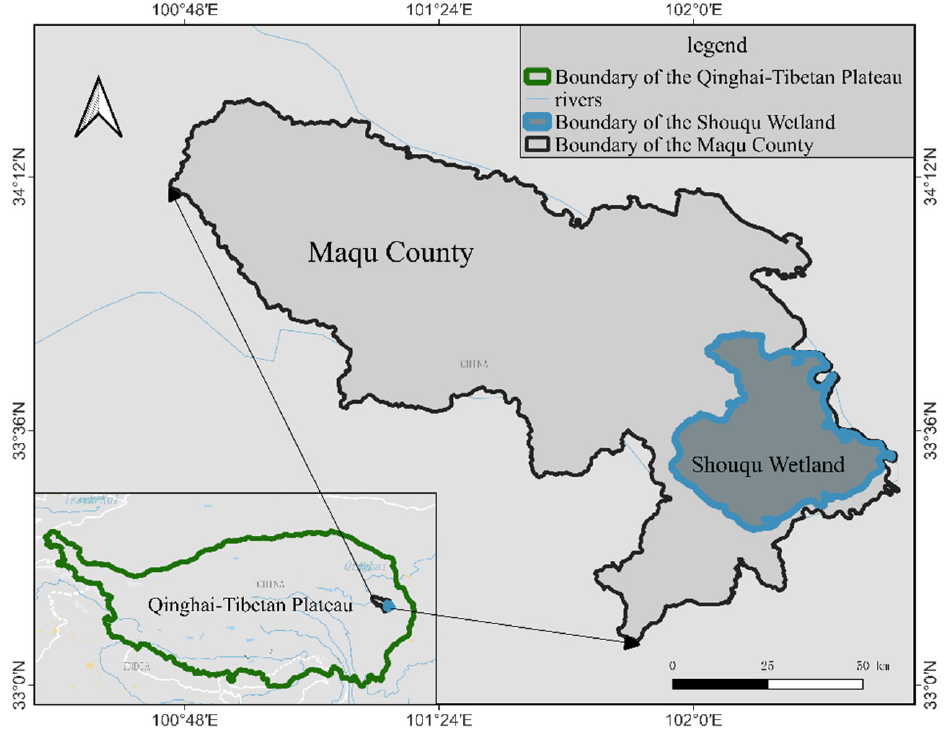
Figure 1. Map showing the location of the study area. The elevation of the region ranges from 3300 to 4806 m, and the terrain is high in the west and low in the east. The study area has a dry and cold plateau continental alpine humid climate, with long winters, extremely short summers [29], a mean annual temperature of 1.2 ◦ C, concentrated rainfall, and annual precipitation of 615.5 mm. Due to its typical wetland types, geographic conditions, and ecological environment, this area is a typical representative of the alpine wetland ecosystem on the